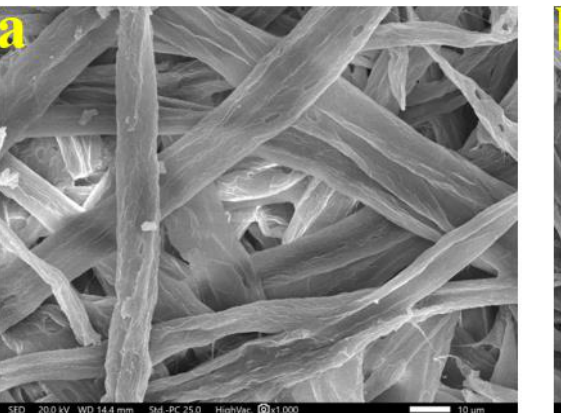
Figure 10. SEM images show inhibition of fungal growth on M. sinclairii WB pulp paper produced with the addition of HeOEs and inoculated with A. flavus : ( a ) with M. azedarach HeOE at 5%; ( b ) with M. grandiflora HeOE at 5%.